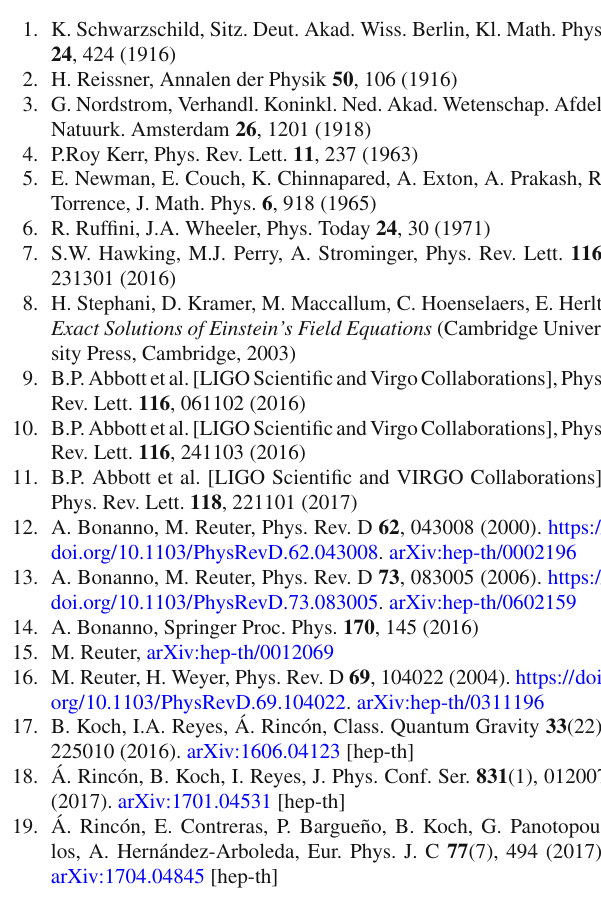
the RN solution i.e.: (i) α = 0 for the RN solution (solid black line), (ii) α = − 0 . 025 (dashed blue line), (iii) α = − 0 . 050 (dotted red line) and finally iv) α = − 0 . 075 (dot-dashed orange line). The rest of the parameters are taken to be